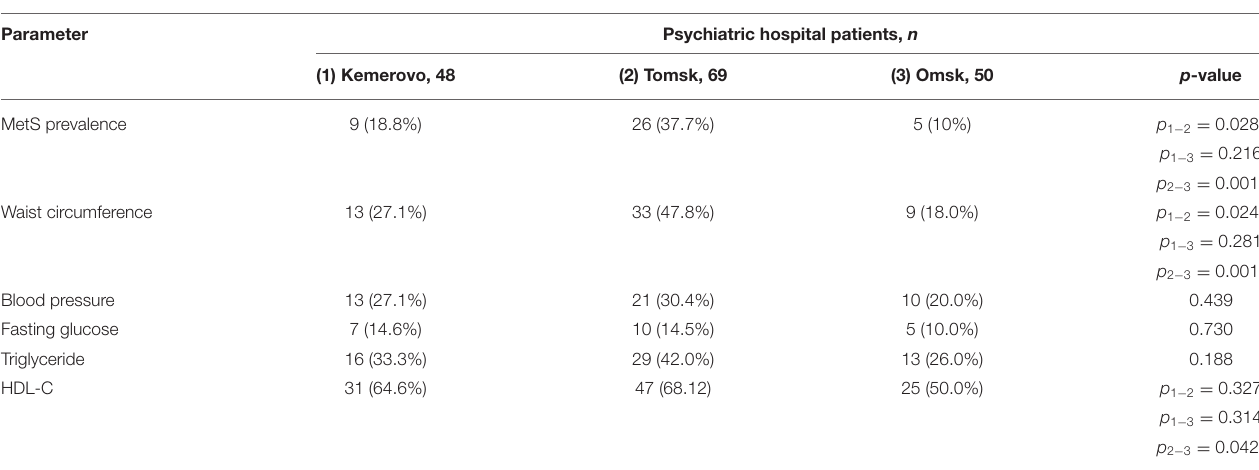
TABLE 11 | Prevalence of MetS and its criteria in the male part of the study population [ n (%)].